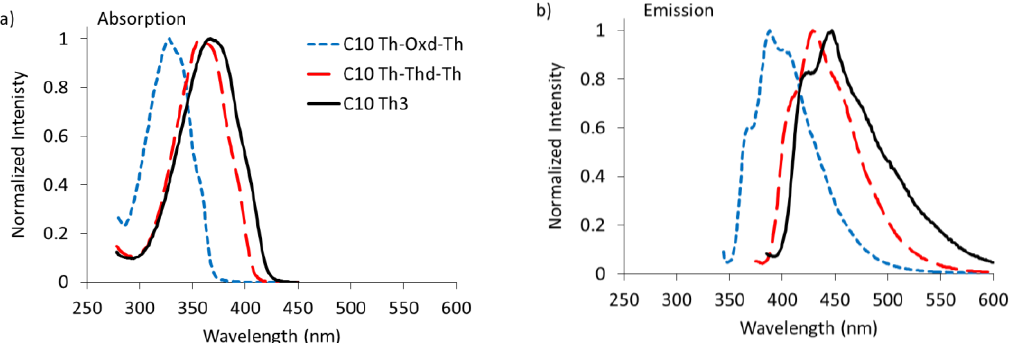
Figure 9. Absorption ( a ) and emission ( b ) spectra of Th 3 (10) , Th-Oxd-Th(10) and Th-Thd-Th(10) in CHCl 3 .